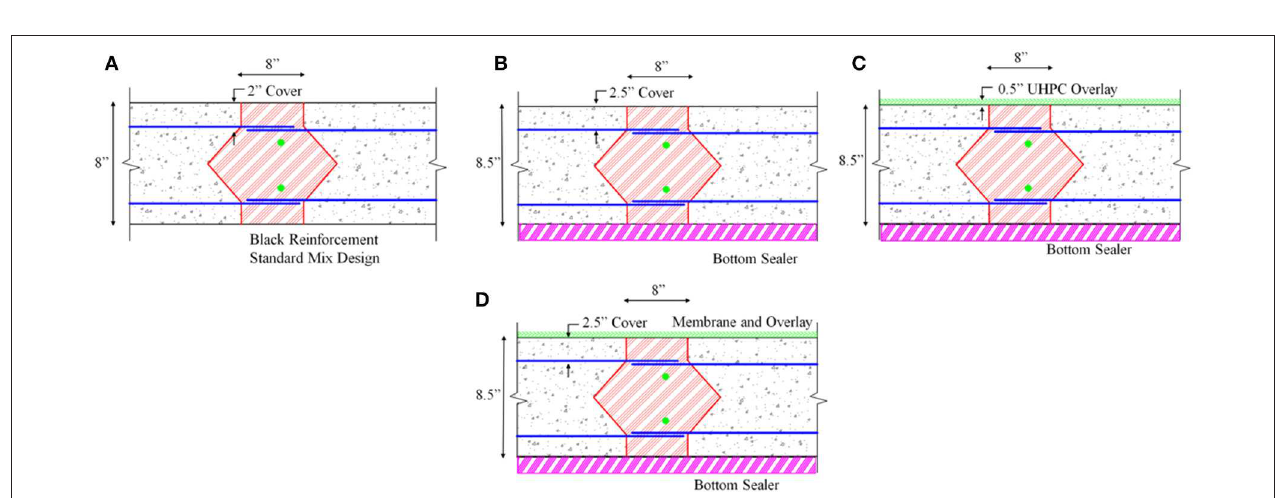
FIGURE 12 | Closure joint Alternative 5, using UHPC with straight bars (A) strength design, (B) Option 1, (C) Option 2, and (D) Option